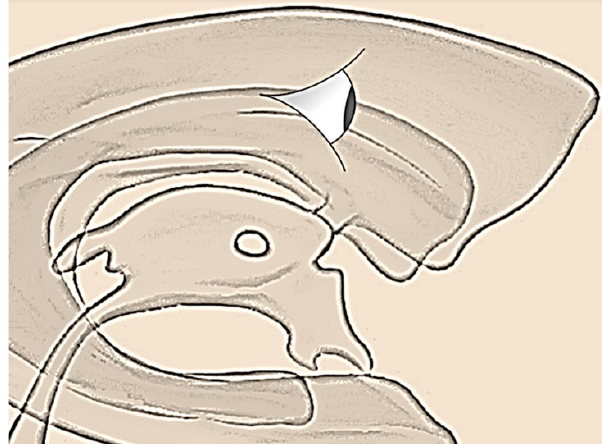
Fig. 7. Direction of the endoscopic viewing angle for frontal horn.